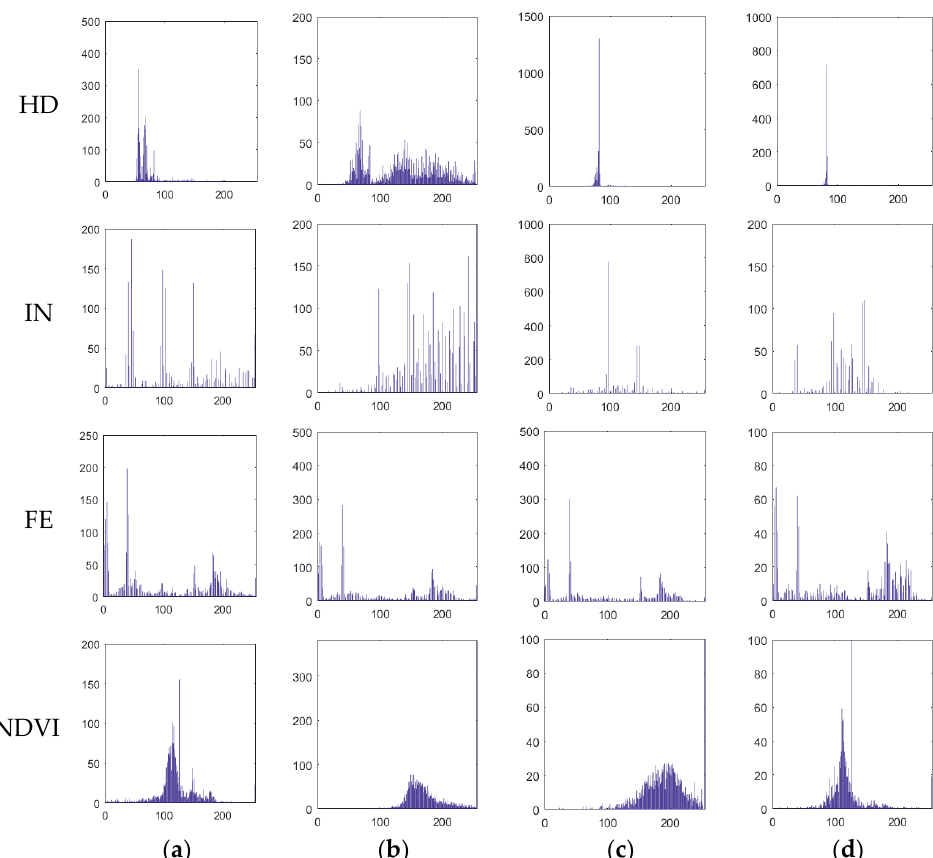
Figure 2. Feature category histogram:( a ) Building; ( b ) Tree; ( c ) Grass; ( d ) Road. Table 1. Thresholds of feature